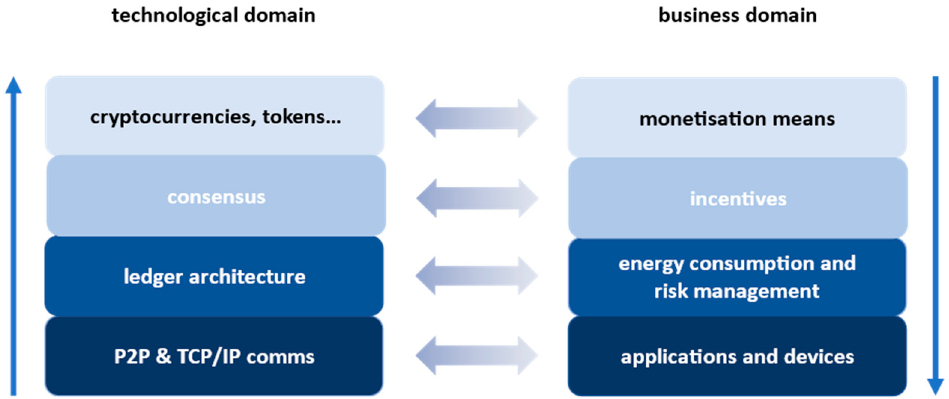
Figure 3. Llinking the technological model (on the left) with the business model (on the right) and the corresponding layers. the corresponding